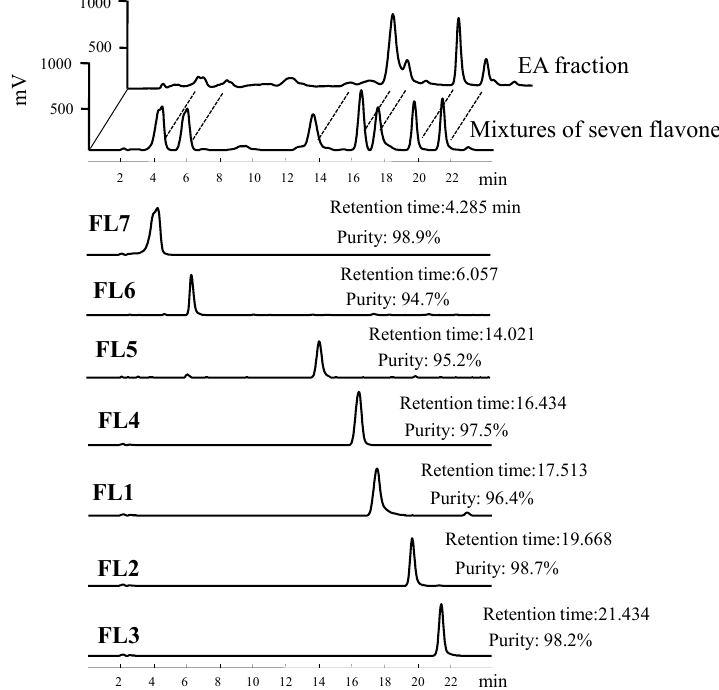
Figure 5. Retention time and purity analysis of FL1 – 7 in HPLC.